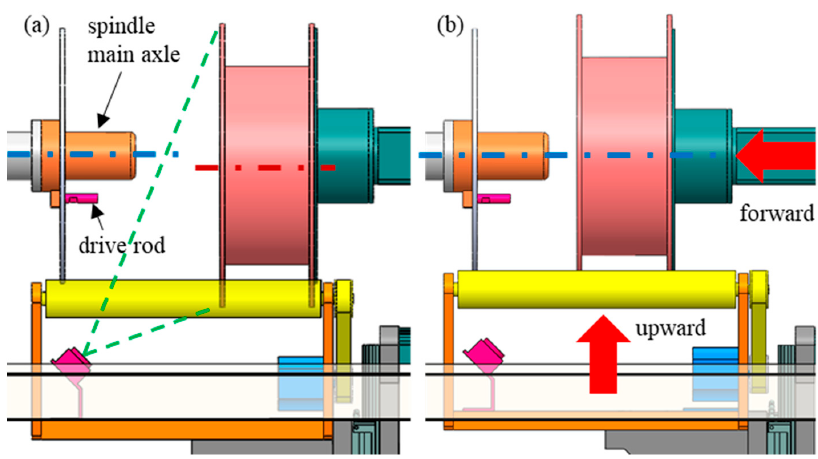
Figure 4. Automatic spool positioning and loading process: ( a ) spool angular position measurement and adjustment; ( b ) spool loading and clamping.